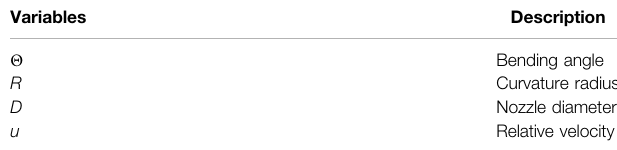
TABLE 1 | The variables used in the formula and models